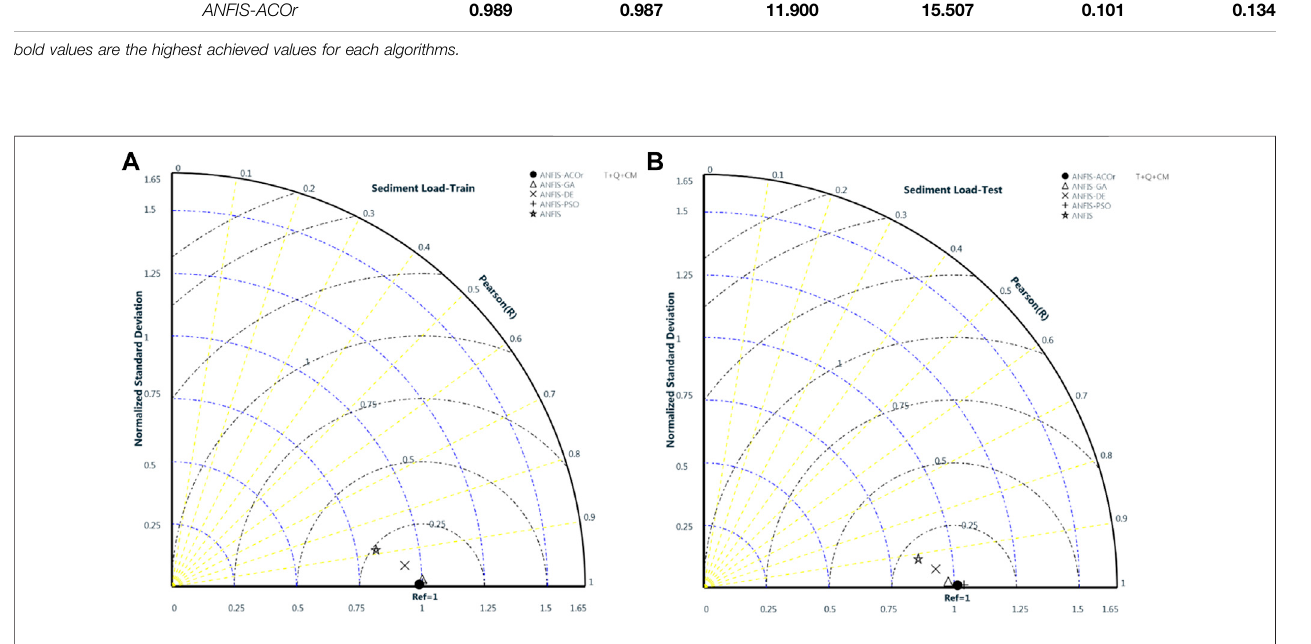
FIGURE 10 | Taylor diagram for Comparison between 5 Hybrid Algorithms in T+Q+CM set data in (A) -Train and (B) - Test phase.